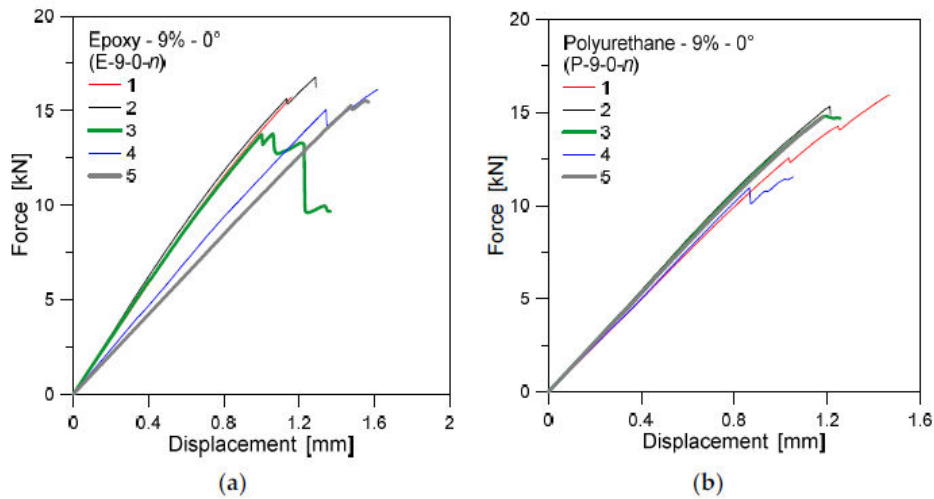
Figure 4. Experimental force–displacement results for specimens with ( a ) epoxy or ( b ) polyurethane glue, under 9% moisture and parallel rod-to-grain arrangement.